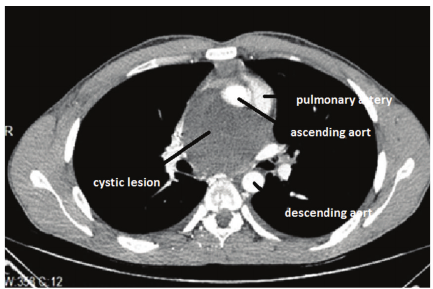
Figure 1: The computerized tomography of the patient showing 8 × 7 cm cystic structure situated above the right ventricle between the aortic arch and right pulmonary artery.